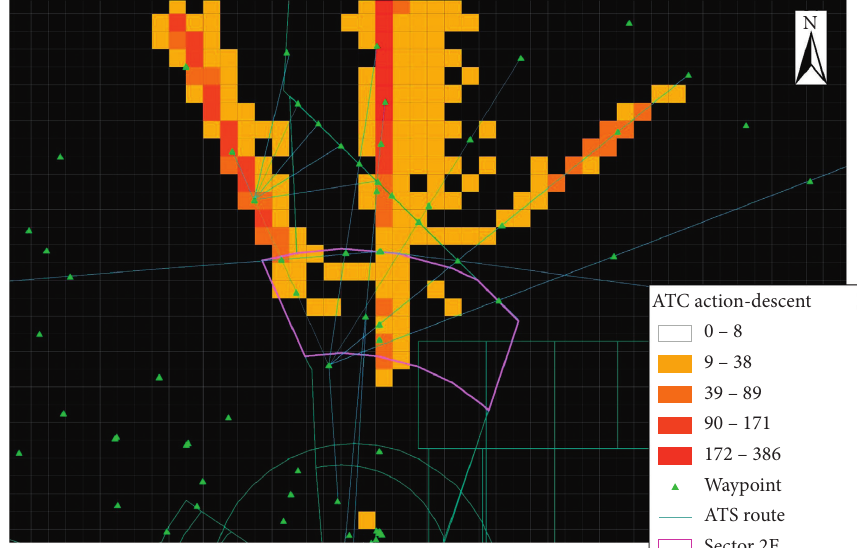
Figure 7: Distribution of ATCO action-descend.